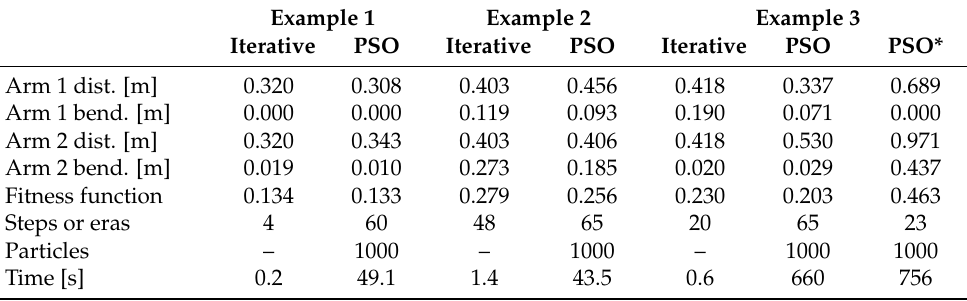
Table 3. Results for the testing workplaces, including the time required to run the corre- sponding optimization algorithm (PSO* denotes the non-optimal solution).